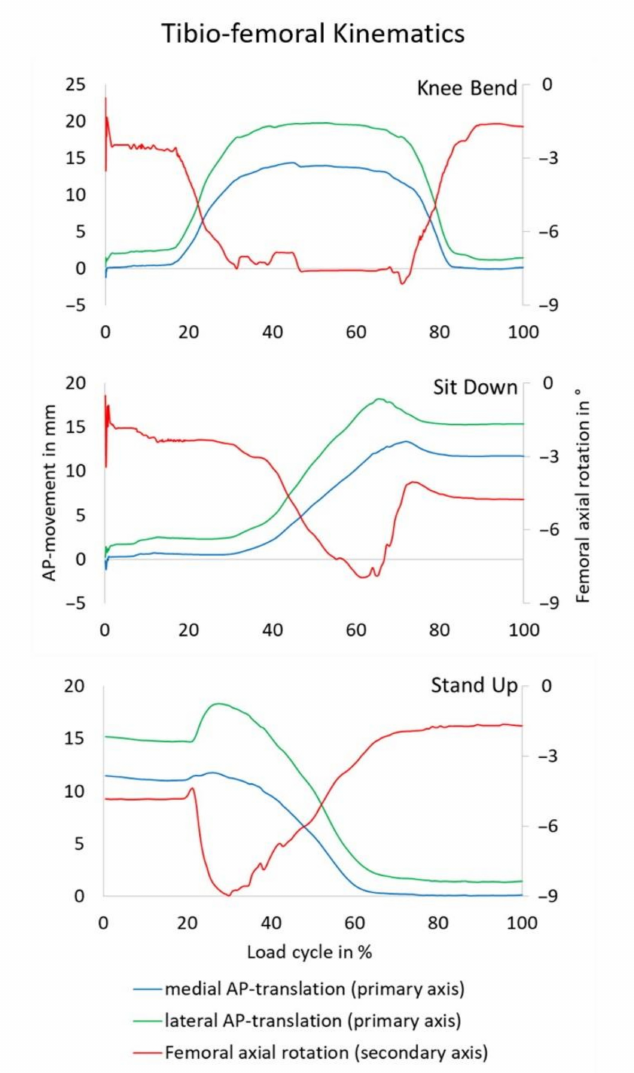
Figure 7. Femoral rollback of medial and lateral condyle and the axial femoral rotation for sit down, stand up, and knee bend